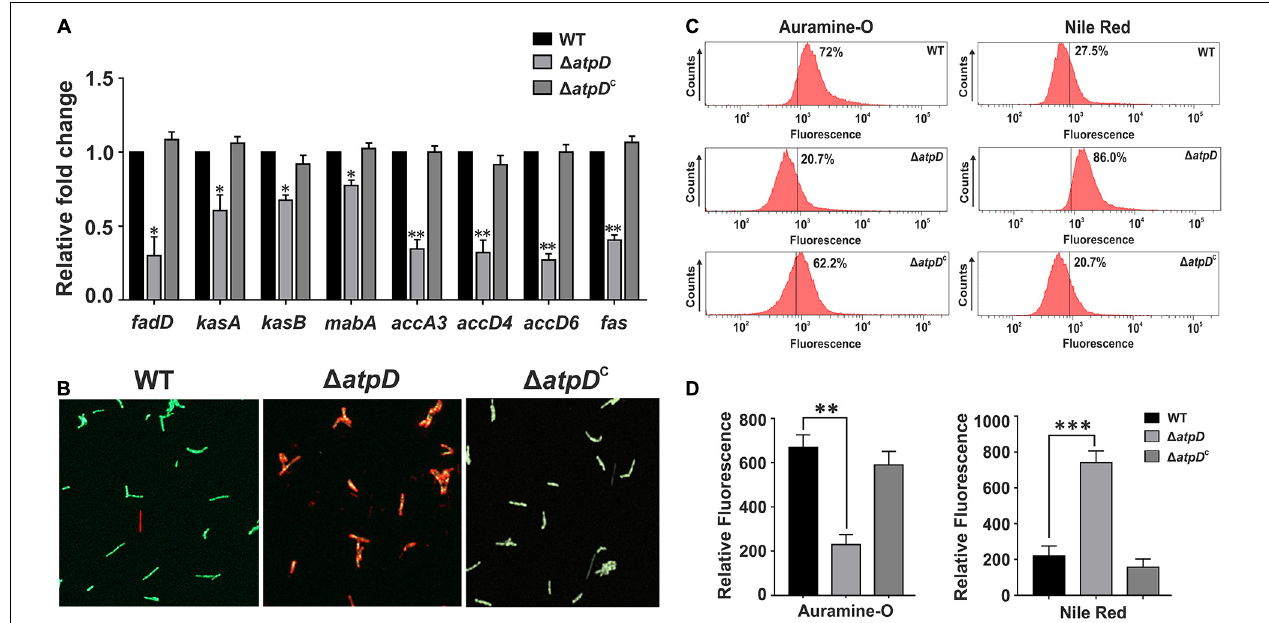
FIGURE 4 | Mycobacterium smegmatis shows reduced mycolic acid levels leading to loss of acid-fastness under energy-compromised state. Panel (A) shows the relative mRNA transcript levels of the genes belonging to the FAS-II and FAS-I lipid biosynthesis pathway genes such as fabD (MSMEG_4325), kasA (MSMEG_4327), kasB (MSMEG_4328), mabA (MSMEG_3150), accA3 (acetyl-CoA carboxylase; MSMEG_1807), accD4 (MSMEG_6391), accD6 (MSMEG_4329), and fas (MSMEG_4757) in M. smegmatis wild-type (WT), atpD knock-out ( (cid:49) atpD ), and atpD -complemented ( (cid:49) atpD C ) strains. The transcript level in each case is compared with that of M. smegmatis wild-type, which is taken as 1. Panel (B) shows the fluorescence microscopy images for the M. smegmatis WT, (cid:49) atpD , and (cid:49) atpD C strains after staining the cells with Auramine-O and Nile red. Panel (C) shows the flow cytometric analysis of all the three strains after staining the cells with Auramine-O and Nile red dye, as mentioned. The percentage value represents the fraction of cells that are positive for that fluorescence. Flow cytometry experiments were repeated at least thrice. Panel (D) shows the quantification by measuring the fluorescence of Auramine-O and Nile red dyes as mentioned on fluorescence plate reader for M. smegmatis WT, (cid:49) atpD , and (cid:49) atpD C strains. In all the panels, the experiments were repeated at least thrice. In both panels (B,C) , only one representative image is shown. In panels (A,D) , error bars represent standard deviation. ∗ P -value < 0.05; ∗∗ P -value < 0.01; ∗∗∗ P -value <